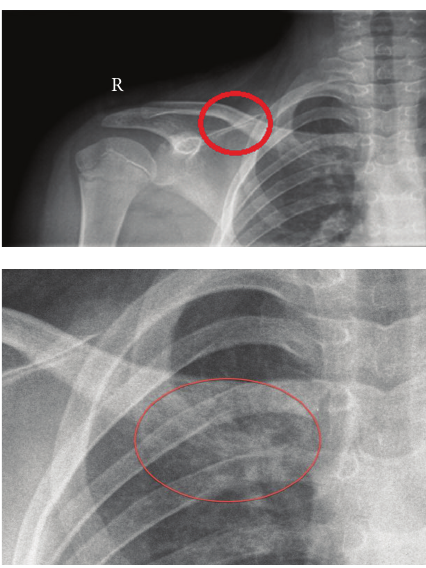
Figure 1: A subtle osteitis is seen. The medial site of the clavicle shows an unclear restriction and a heterogeneous aspect.